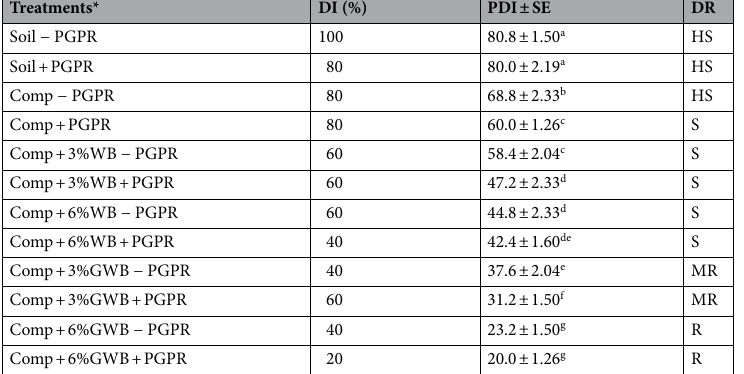
Table 3. Effect of different soil substrate compositions and plant growth promoting rhizobacteria (PGPR) on disease incidence, percent disease index and disease responses of tomato plant against Alternaria solani. *All treatments were inoculated with Alternaria solani. DI disease incidence, PDI ± SE percent disease index ± standard error, DR disease response, R resistant, MR moderately resistant, S susceptible, HS highly susceptible.